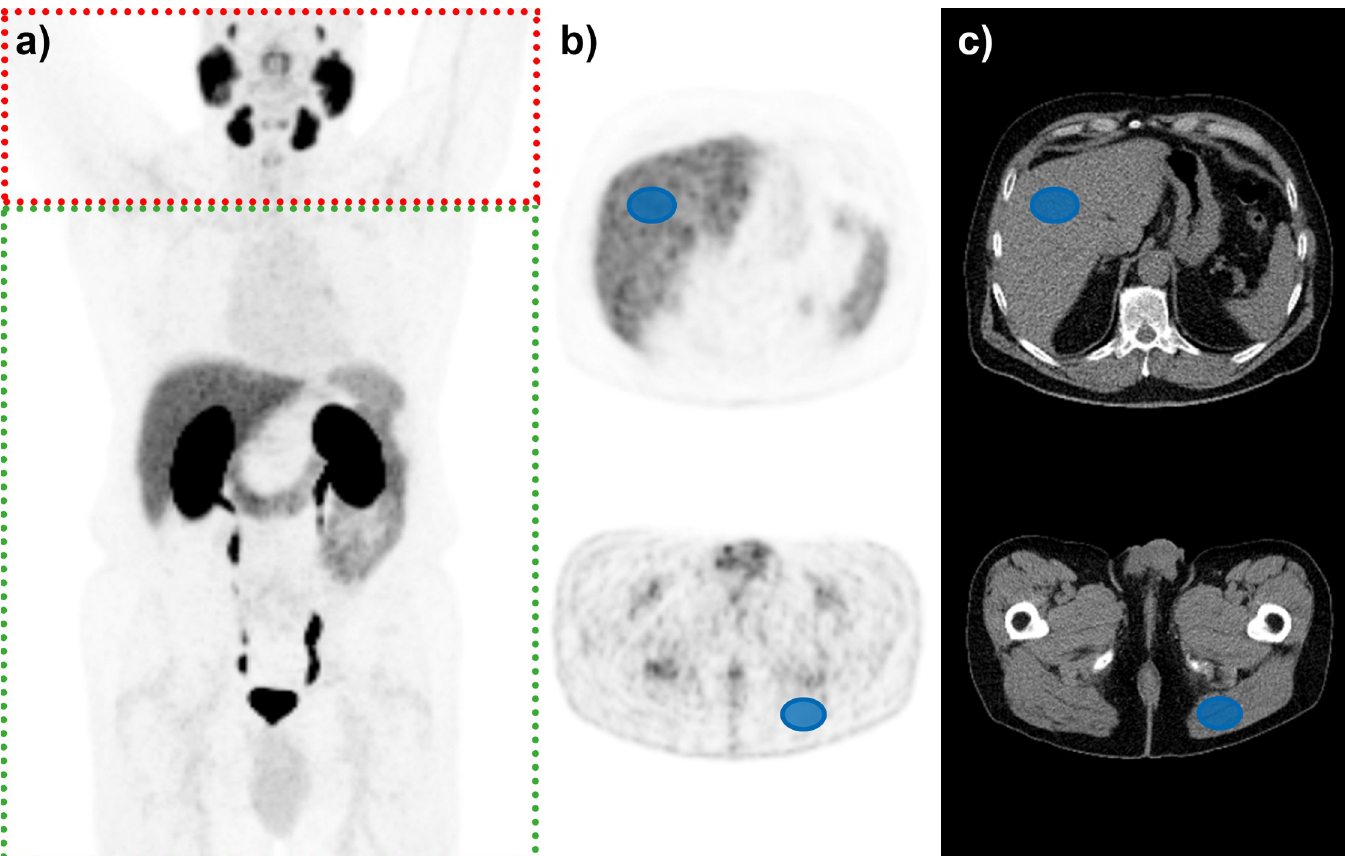
Fig 2. Exemplary PET dataset (a) and placement of VOIs (b,c). Red-dotted area was excluded from the analysis to avoid spillover into bone voxels caused by uptake in salivary and lacrimal glands.